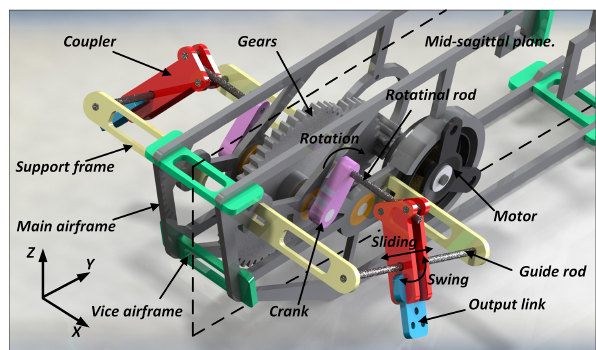
Figure 1. Axonometric drawing of CAD model of mechanism.